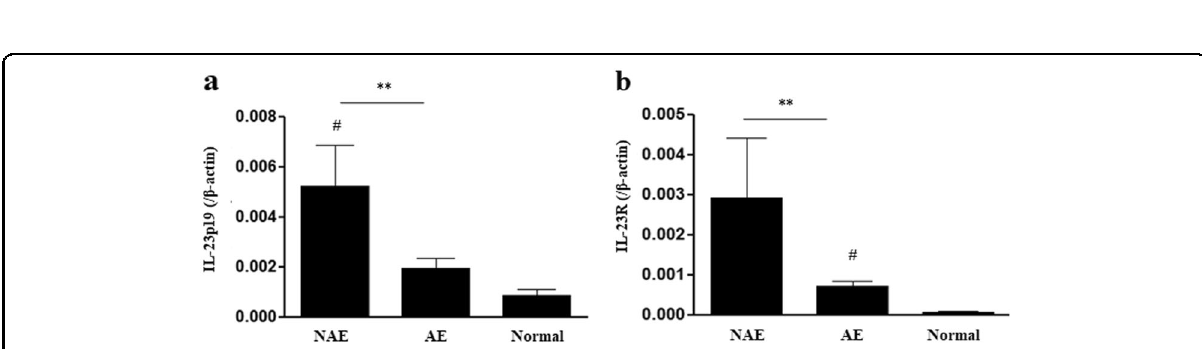
Fig. 9 IL-23A and IL-23R gene expression levels in induced sputum obtained from patients with nonallergic eosinophilic asthma, allergic eosinophilic asthma, and normal controls. a IL-23A. b IL-23R. ** P < 0.01 between two groups; # P < 0.05 compared to normal controls; NAEA nonallergic eosinophilic asthma; AEA allergic eosinophilic asthma (details are provided in the supplementary